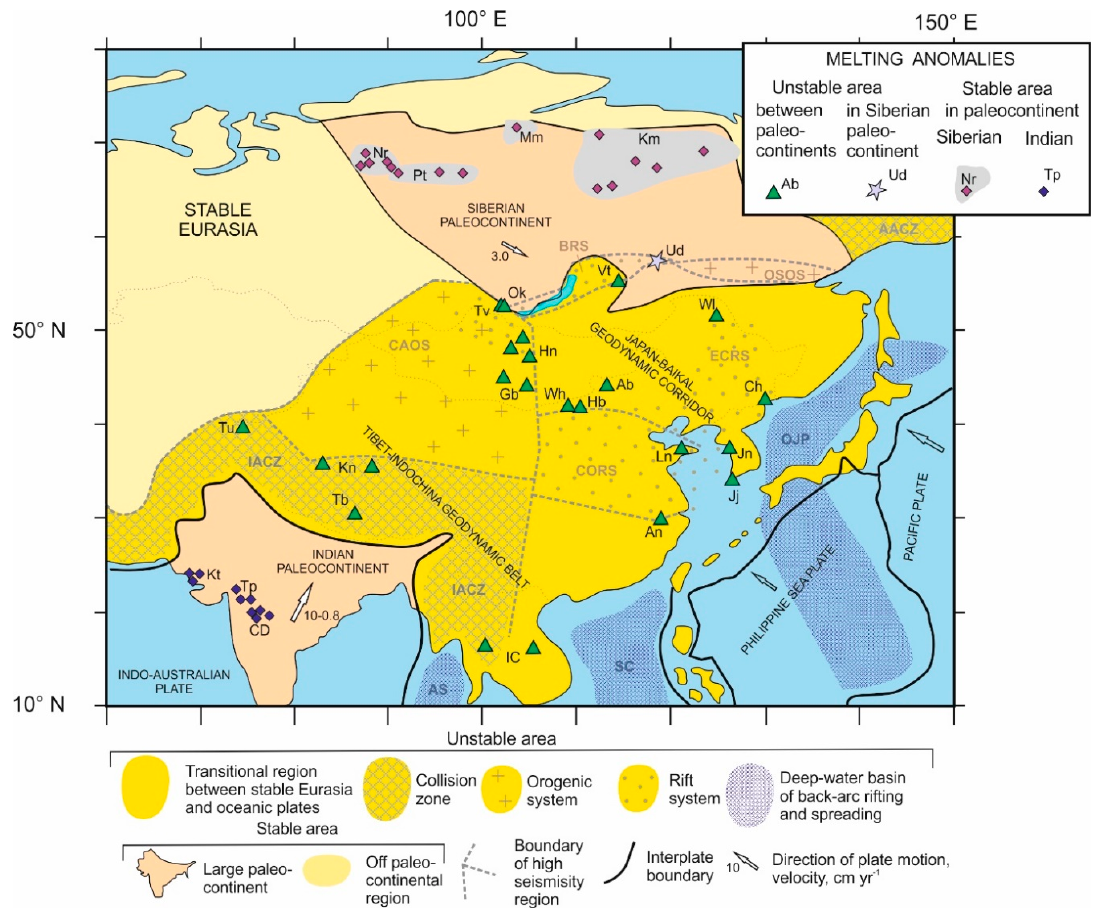
Figure 1. Distribution of selected late Phanerozoic melting anomalies in unstable and stable parts of